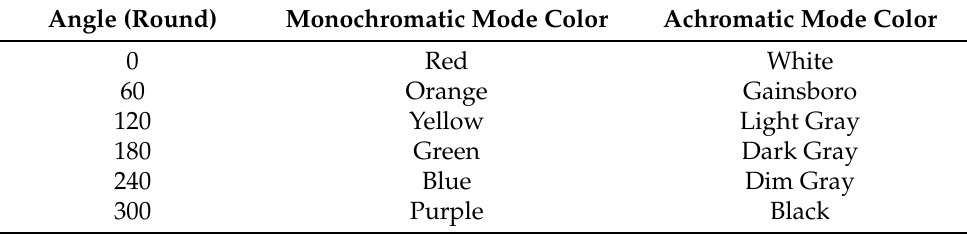
Table 2. Round disk angle chroma-lightness levels for monochromatic and achromatic colors (0–180° and 270° on the square disk,